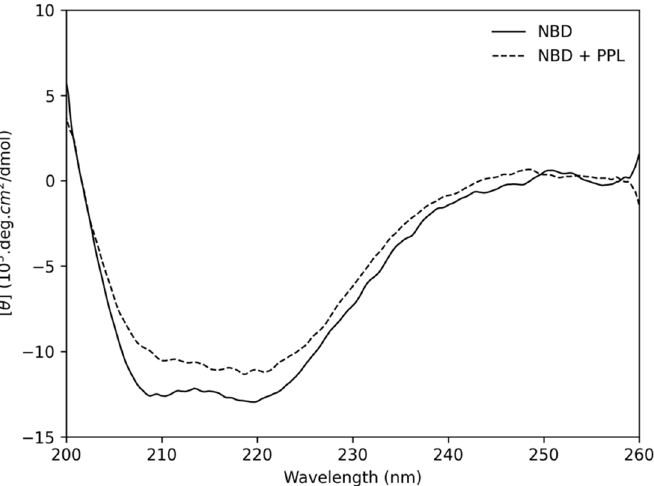
Figure 8. Circular Dichroism of free NBD (solid lines) and NBD + PPL at the stoichiometry 1:12 (dotted lines) at 293 K.